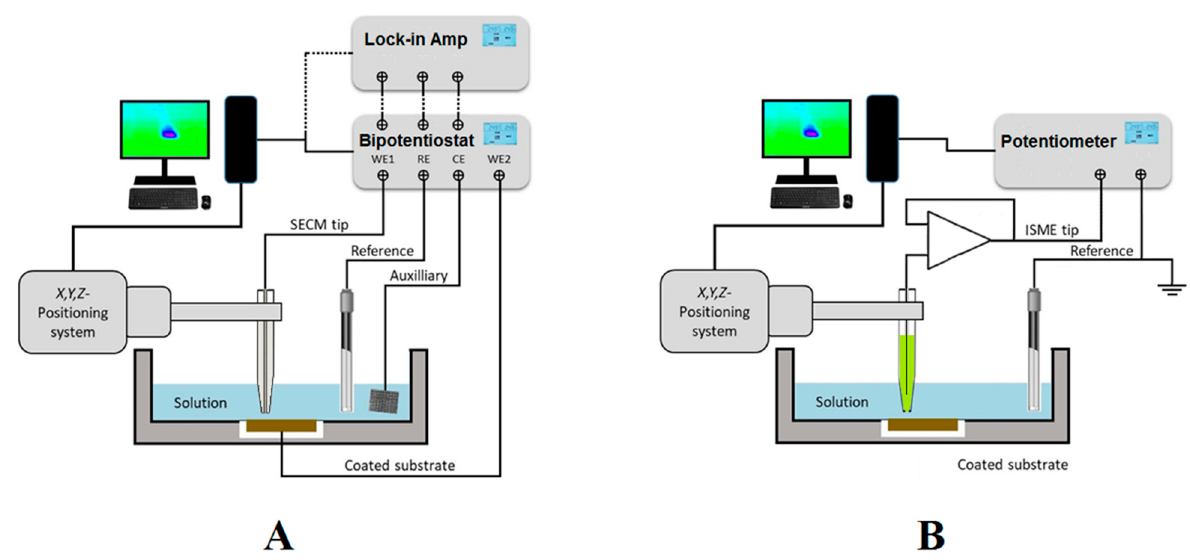
Figure 2. Sketches depicting the SECM set up and electrode connections for ( A ) amperometric and AC operations; and ( B ) potentiometric operation.